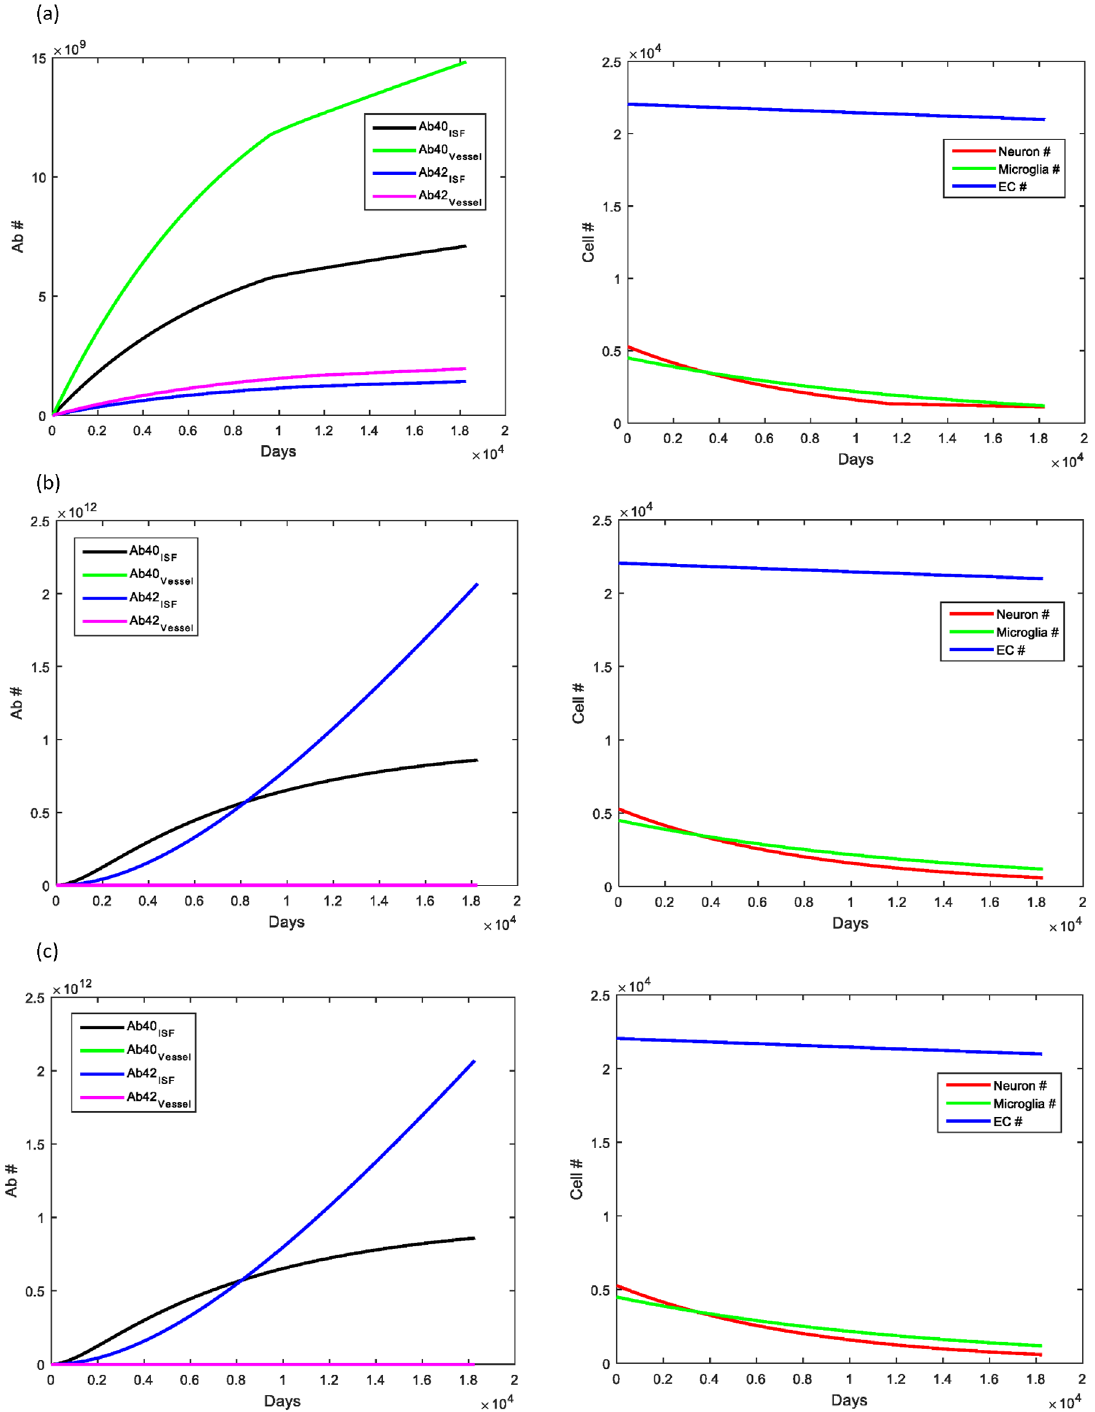
Fig 7. Combination effect of bradycardia, ApoE4 allele and increased vessel stiffness. (A) Having both bradycardia and the ApoE4 allele led to elevated levels of A β 40 deposition in both the brain parenchyma and the cerebral vessels, with nearly a two-fold increase in A β 40 in the cerebral vessels. There was a small decrease in the number of neurons at the final simulation endpoint ( < 10%). (B) In the case where the simulated patient was supposed to have cardiovascular disease (represented by increased vessel stiffness) and carry the ApoE4 allele, A β deposition was significantly elevated within the brain parenchyma (100x and 1000x for A β 40 and A β 42, respectively). The decreased levels of A β within the cerebrovasculature was not quite as significant as with increased vessel stiffness alone, suggesting that the ApoE allele plays an important role in determining deposition and A β concentration within the space